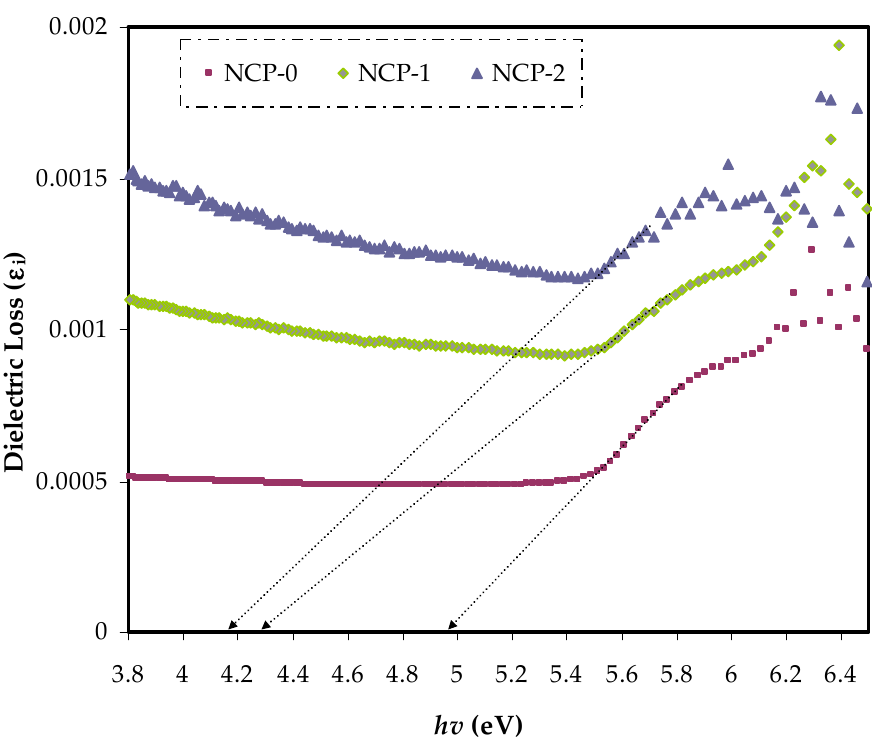
Figure 7. Dielectric loss spectra v wavelength for NCP-0 and composite films.